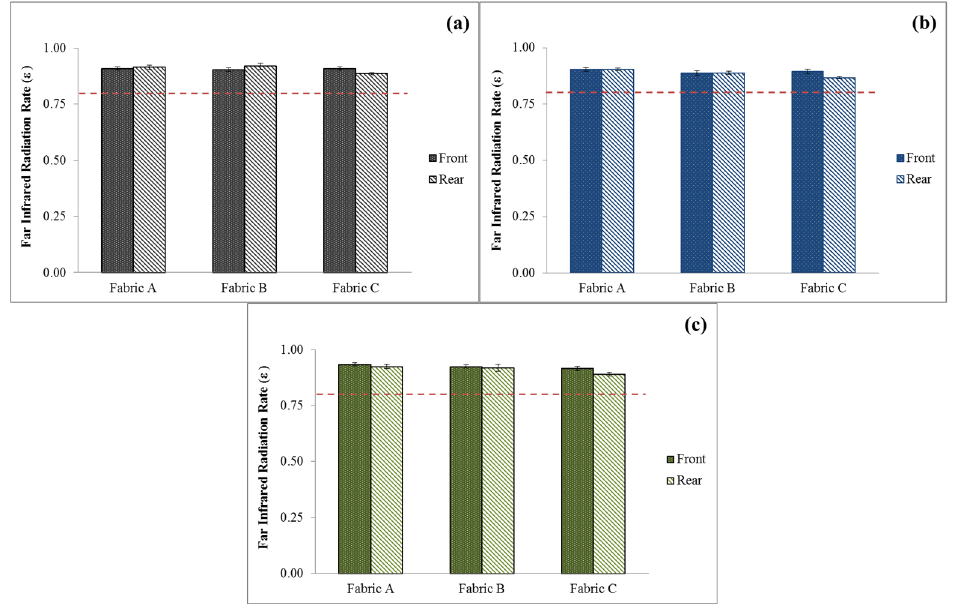
Figure 9. Far-infrared emissivity of elastic warp-knitted fabrics (Fabrics A, B, and C) made by BC ( a ); Figure 9. Far ‐ infrared emissivity of elastic warp ‐ knitted fabrics (Fabrics A, B, and C) made by BC PC ( b ) and BPC ( c ) ring-spun complex ( a ), PC ( b ) and BPC ( c ) ring ‐ spun complex yarns.